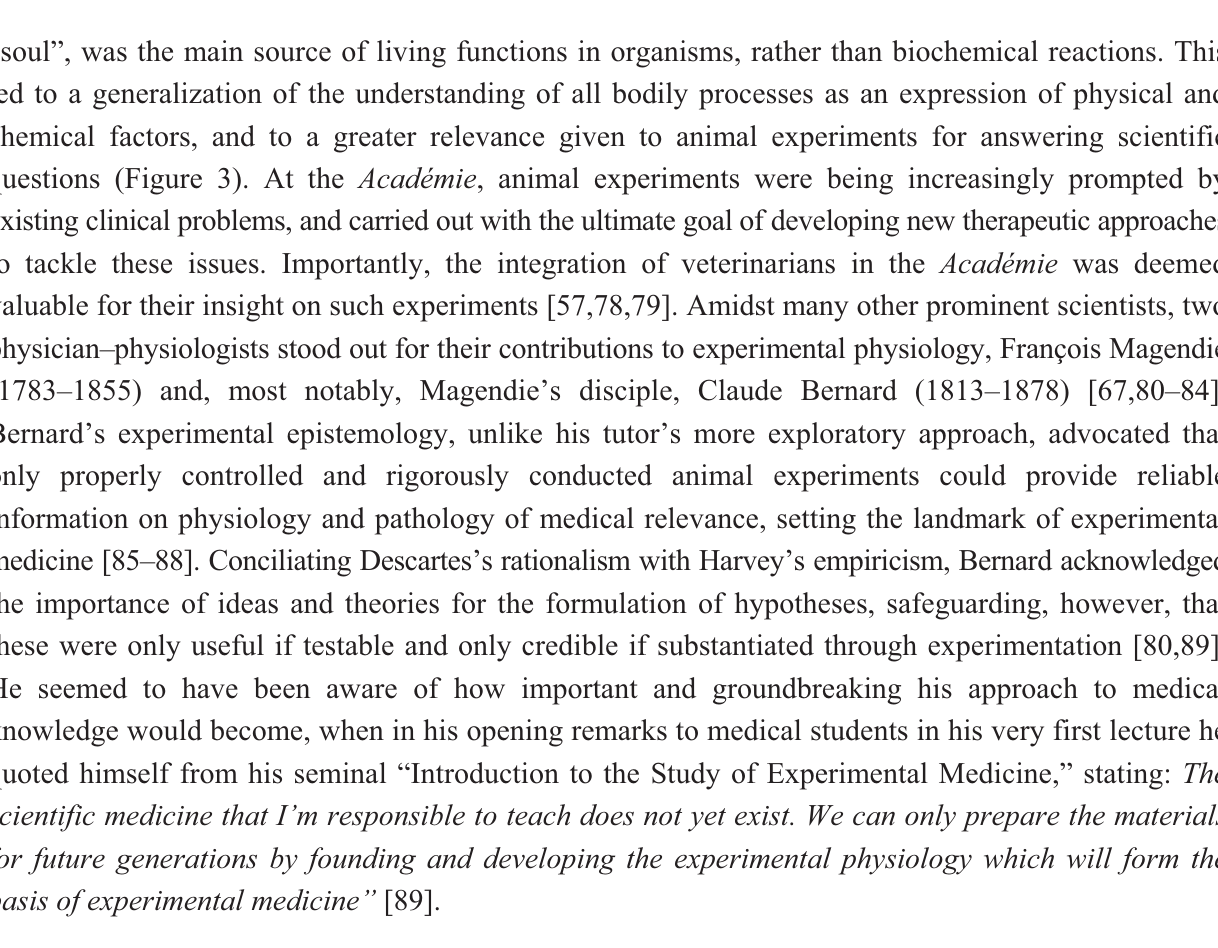
Figure 3. “A physiological demonstration with vivisection of a dog,” by Émile-Édouard Mouchy. This 1832 oil painting—the only secular painting known of the artist—illustrates how French scholars valued physiological experimentation in service of scientific progress [90]. Notice how the struggling of the animal does not seem to affect the physiologist or his observers. Currently part of the Wellcome Gallery collection,